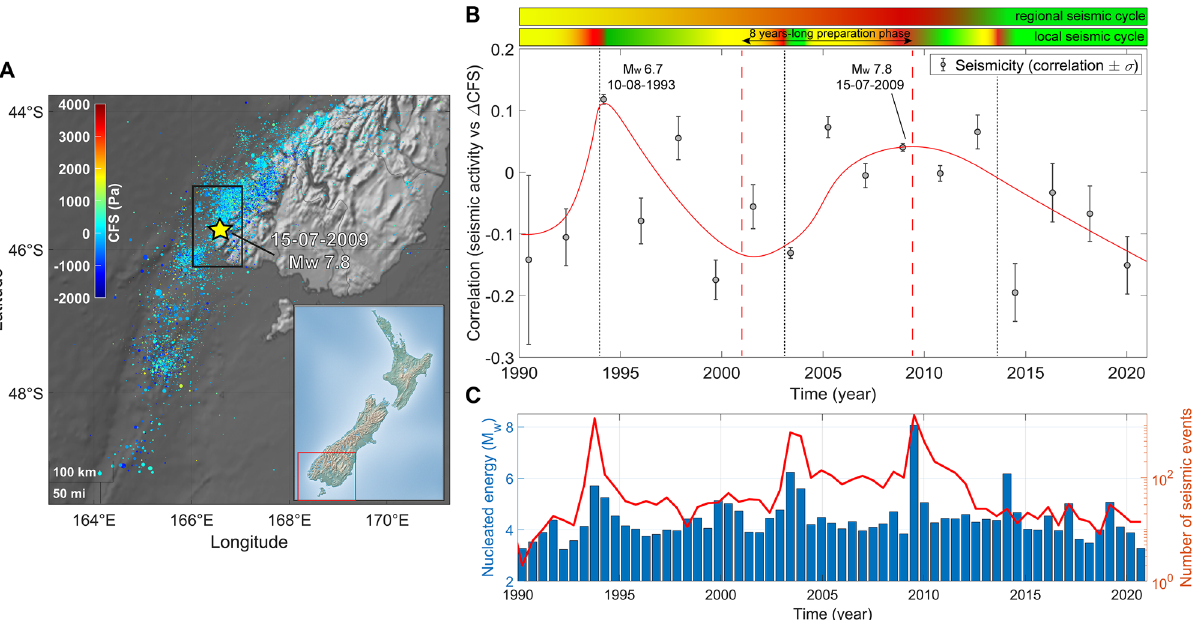
Figure 2. ( A ) (cid:31) CFS map for seismicity in Fiordland region, South Island, New Zealand, GeoNet Catalog, 1990−2021, M L ≥ 2.5. The map is realized using the functions “geoscatter” and “geobasemap” in the Matlab environment 63 . ( B ) Correlation ρ between (cid:31) CFS and seismicity in Fiordland, New Zealand (latitude 45.3°−46.2° S and longitude 166.0°−167.0° E, depth 0−33 km) between 1990 and 2021. An about six years long preseismic phase is detected before the 2009 Fiordland earthquake. The red line is a weighted smoothing spline. Two horizontal color bars above the scatter plot show nested “seismic cycles” whose phases are highlighted by different colors (green for the post-seismic phase, the interseismic one is in yellow and the coseismic phase is in red). ( C ) Histogram of energy nucleated by earthquakes with M L ≥ 2.5 (blue bars) and plot of the number of recorded seismic events (red